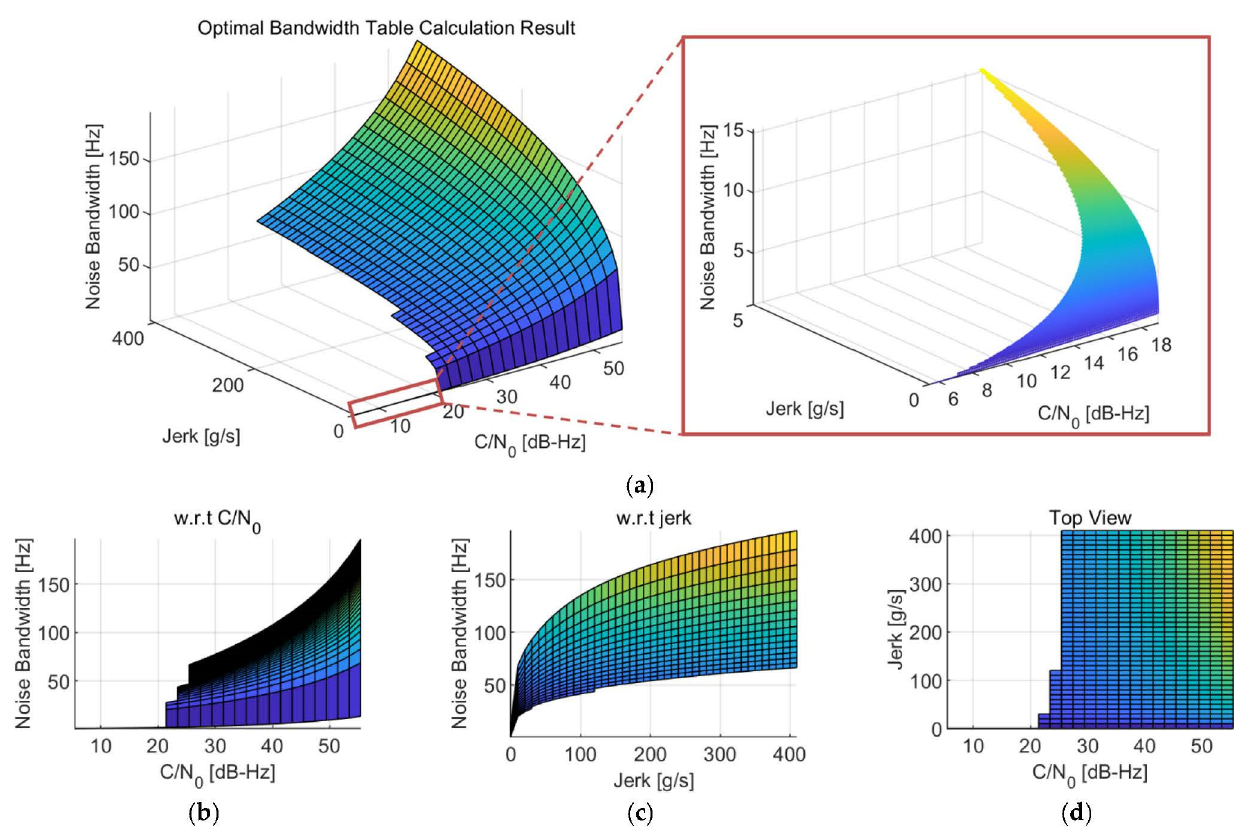
Figure 6. Result example of the generated optimal bandwidth table: ( a ) Overall shape; ( b ) Optimal bandwidth with respect to the C/N 0 ; ( c ) Optimal bandwidth with respect to the jerk; ( d ) Top view.